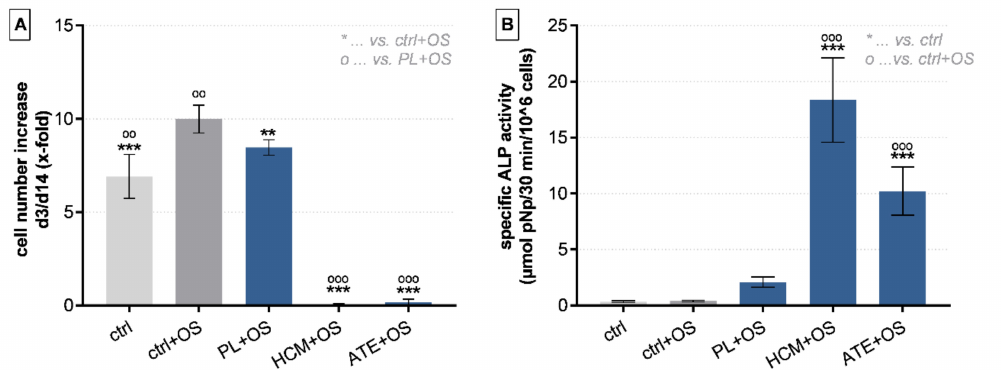
Figure 3. E ff ect of growth factor mixtures on proliferation and osteogenic di ff erentiation of BM-MSCs. ( A ) Cell number increase from day 3 to day 14 and ( B ) specific ALP activity after 14 days of cultivation (mean ± SD, n = 6; ** / ◦◦ p < 0.01, *** / ◦◦◦ p < 0.001). OS: osteogenic